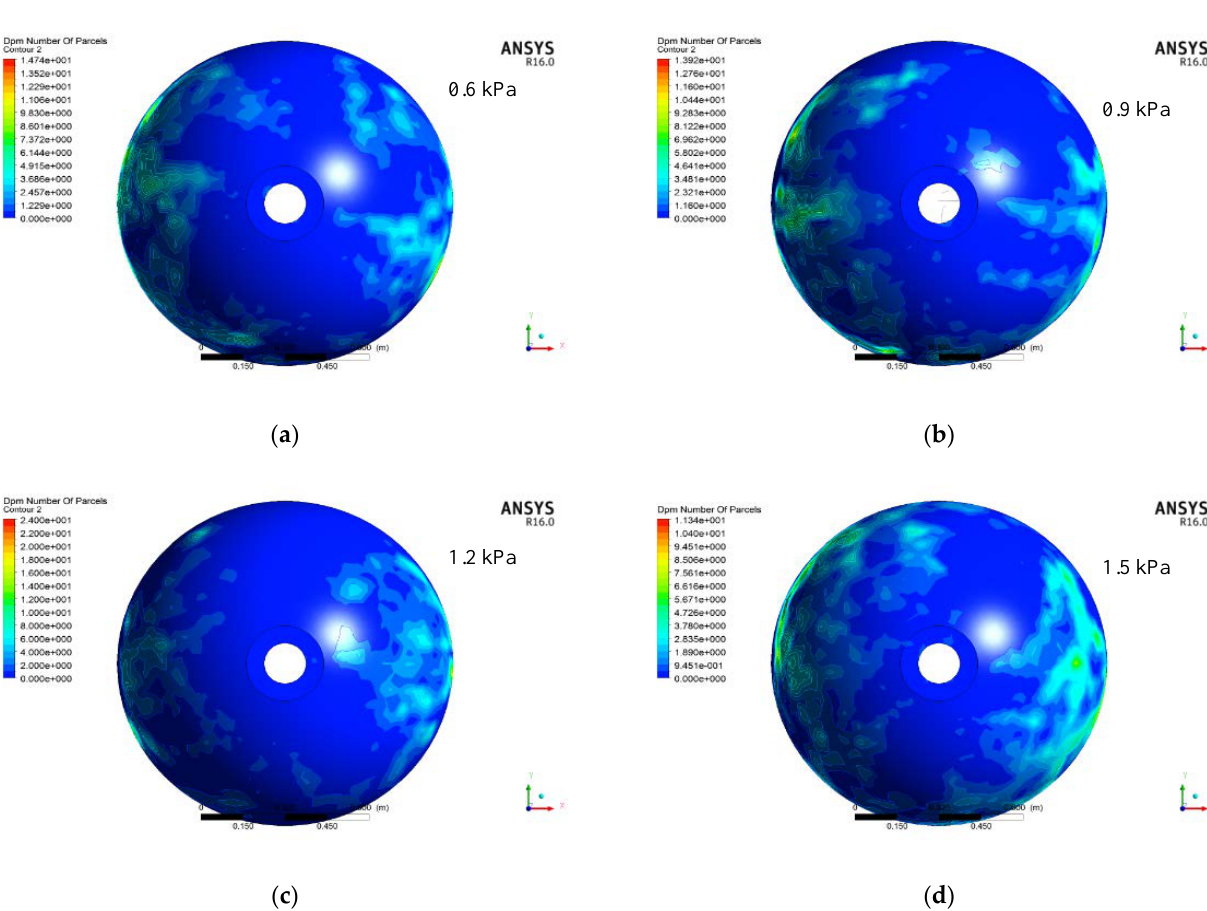
Figure 26. Mist deposition distribution on the cover: ( a ) 0.6 kPa; ( b ) 0.9 kPa; ( c ) 1.2 kPa; ( d ) 1.5 kPa.